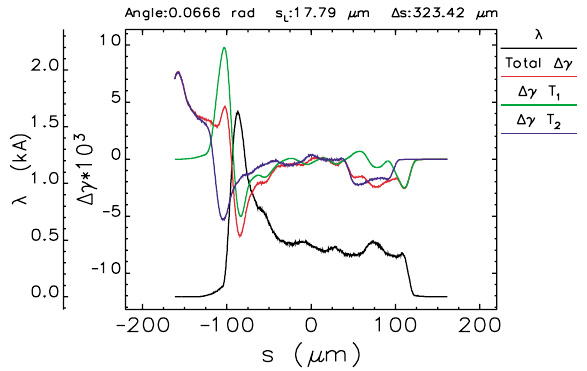
FIG. 7. (Color) Bunch distribution and CSR wakes at the center of the fourth dipole.